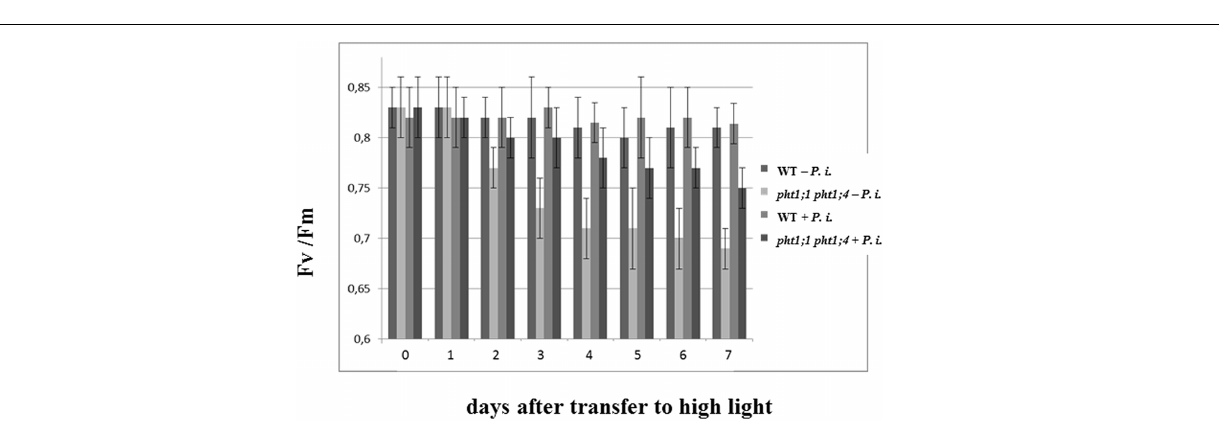
FIGURE 7 | Piriformospora indica promotes the efficiency of the photosynthetic electron transport of the double knock-out line exposed to high light stress under Pi limitation. Chlorophyll fluorescence measurements (Fv/Fm) for P. indica -exposed WT and pht1;1 pht1;4 seedlings which were transferred to fresh PNM plates with LP and high light intensity (300 µ mol m − 2 s − 1 ) for 1 week (cf. Materials and Methods). Based on three independent experiments with 16 plants each. Bars represent SEs.